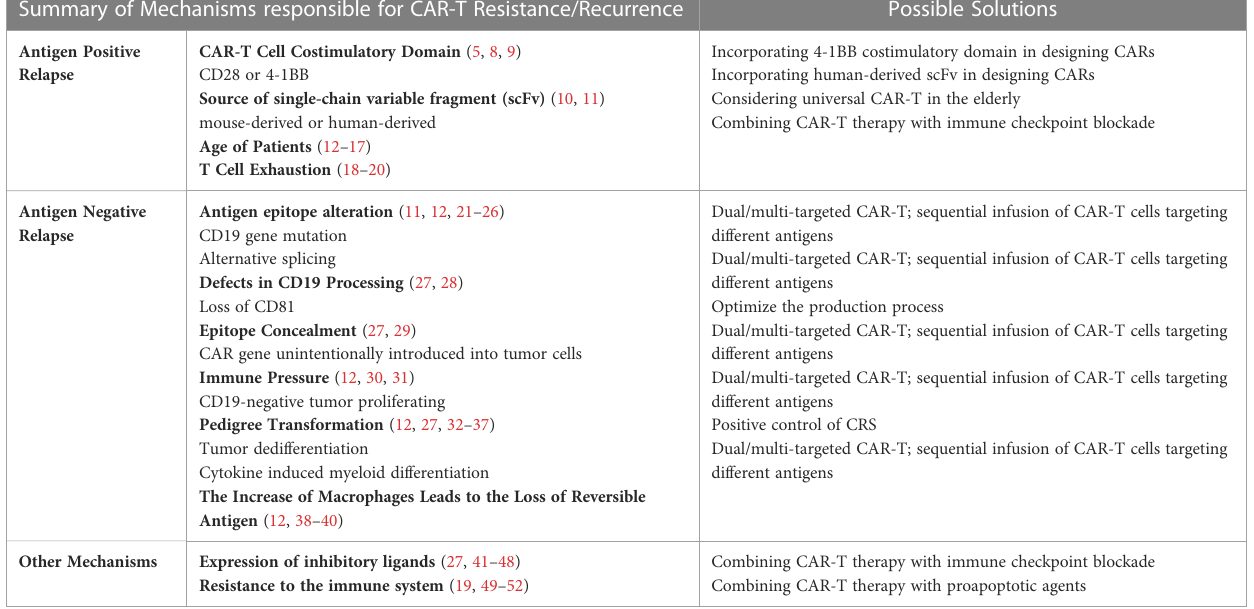
TABLE 1 Summary of mechanisms responsible for CAR-T resistance/recurrence and possible solutions. Summary of Mechanisms responsible for CAR-T Resistance/Recurrence Possible